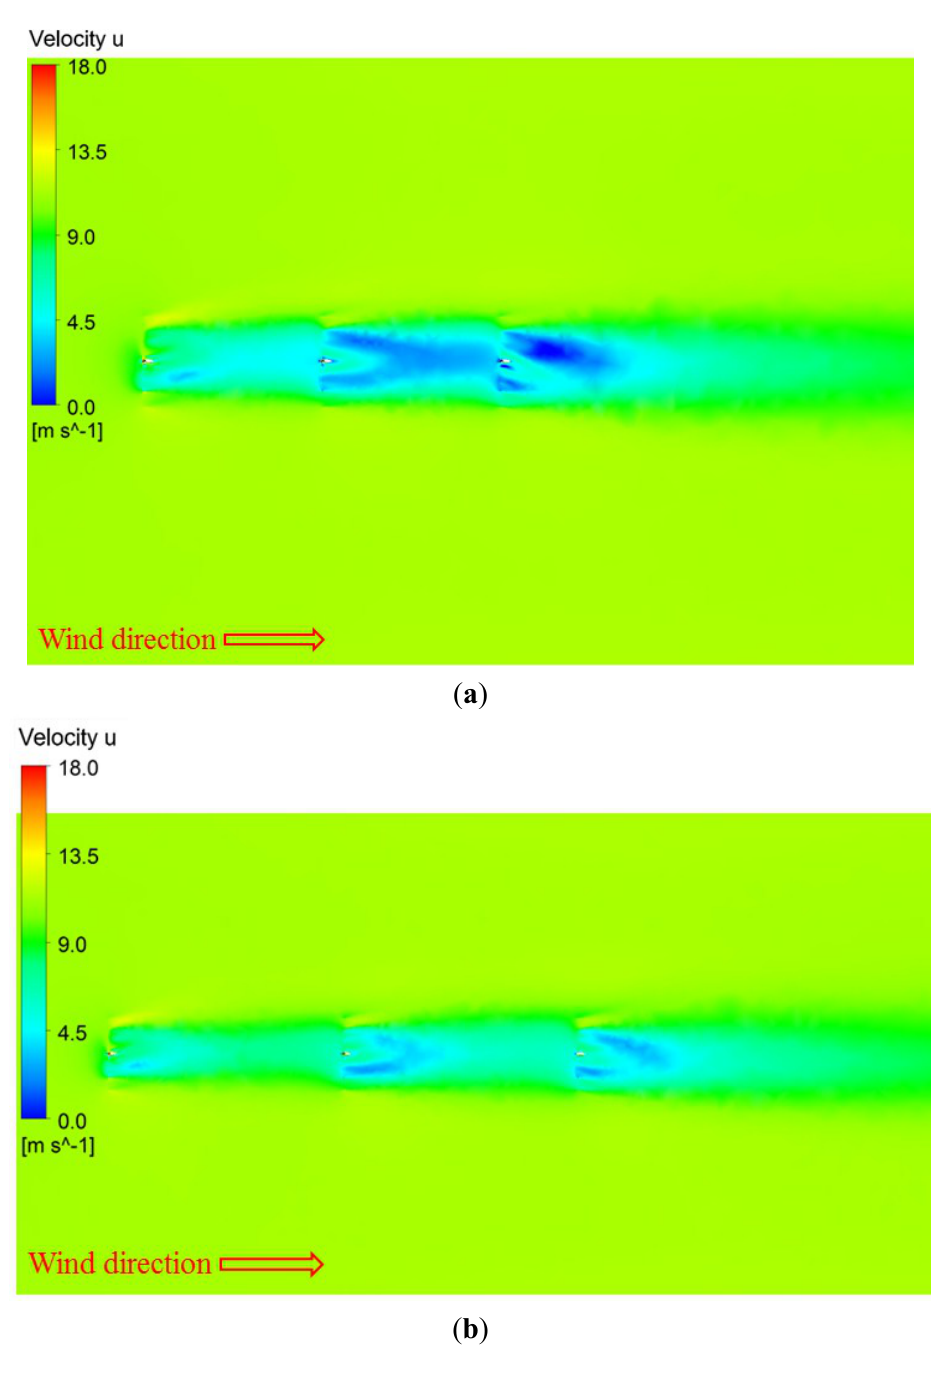
Figure 6. Axial direction wind speed contours in horizontal plane at the reference